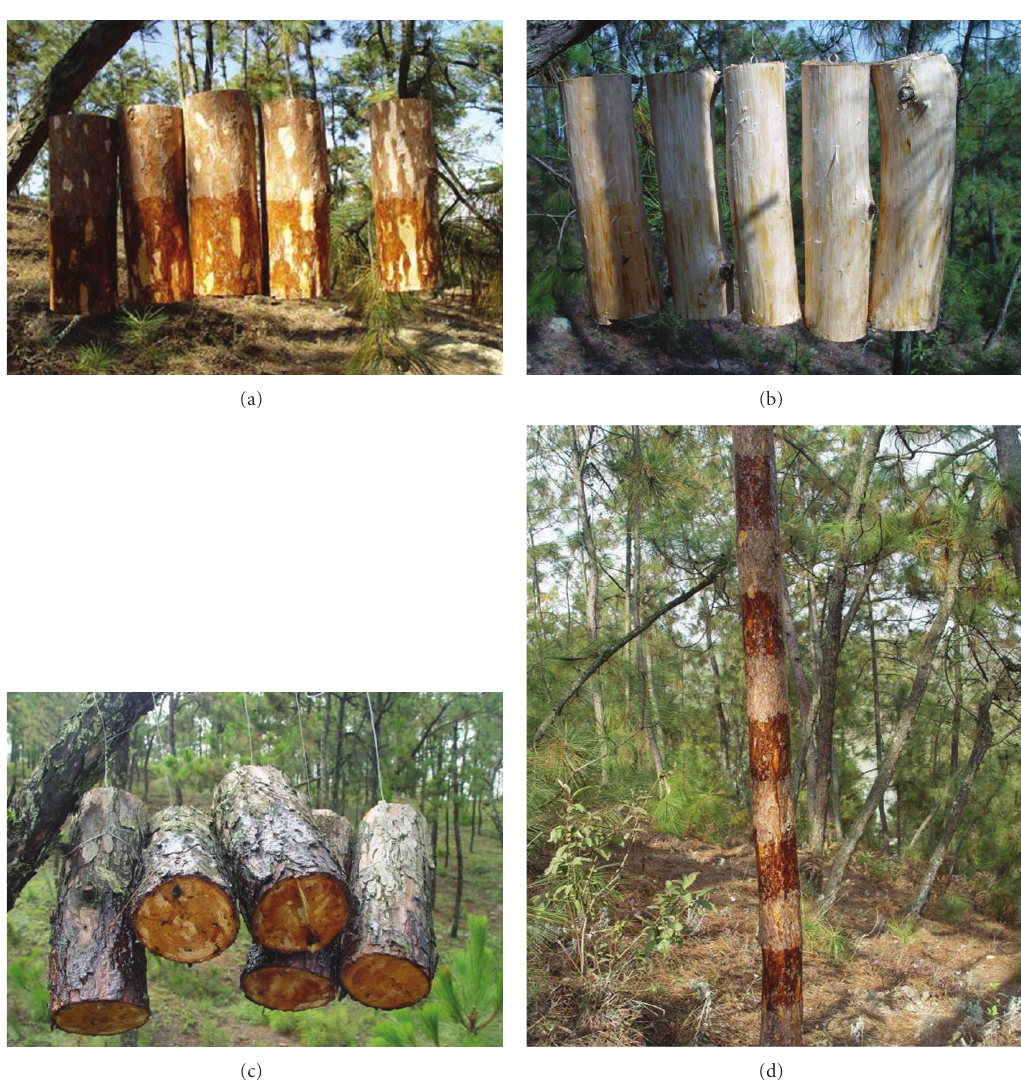
Figure 1: (a) Trap log bundles with periderm peeled o ff . (b) Trap log bundles with periderm and phloem peeled o ff . (c) Intact (not peeled) trap log bundles. (d) Standing Yunnan pine tree with periderm peeled o ff and every other 15 cm section covered with sticky adhesive (Qujing, Yunnan,